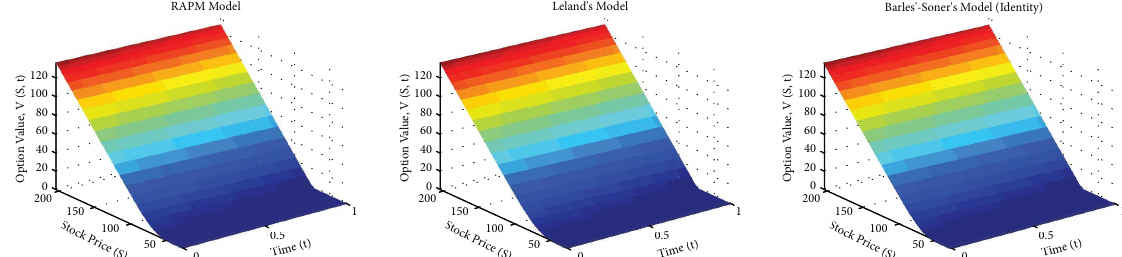
Figure 2: Different types of volatility models by differential quadrature method. Here, we use K � 75, T � 1, R � 1, N � 40, m � 2500, σ � 0 . 2, r � 0 . 1, a � 0 . 02, Le � 0 . 6, M � 2, and C � 0 . 01.